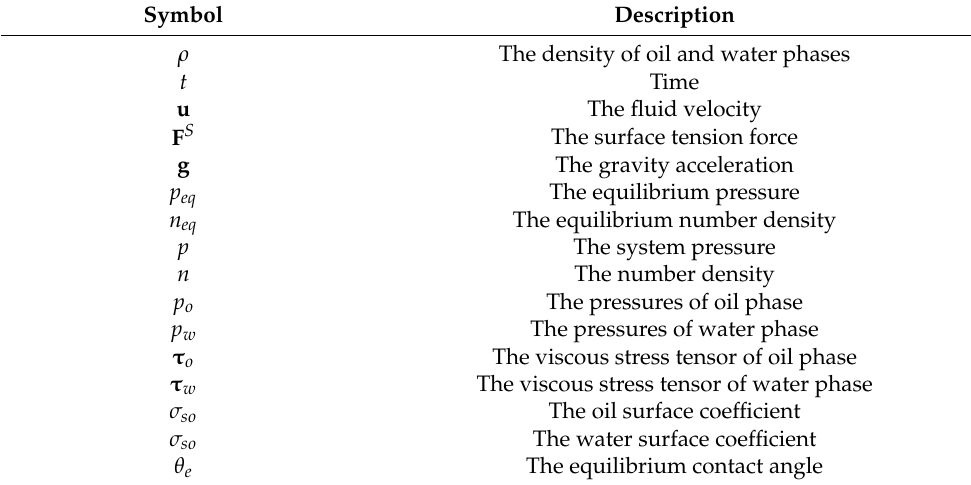
Table 1. Table of